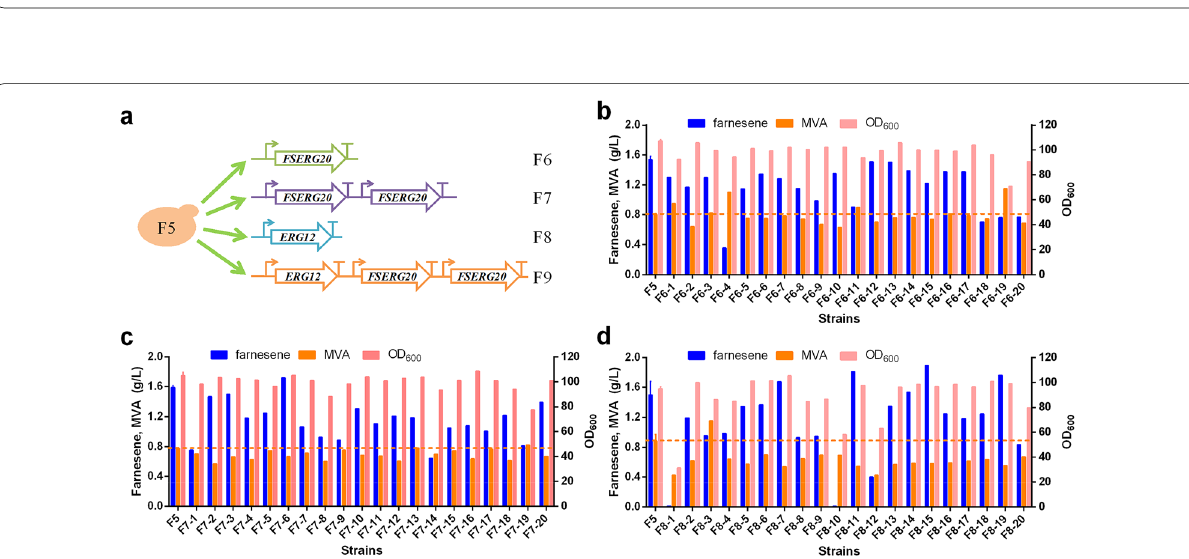
Fig. 3 α-Farnesene, mevalonate accumulation and OD 600 of recombinant strains randomly selected from F6, F7 and F8 libraries. a The genetic information of the F6, F7 and F8 strains. b – d α-Farnesene, mevalonate production and OD 600 of different transformants randomly selected from F6, F7 and F8 libraries were compared at 96 h,